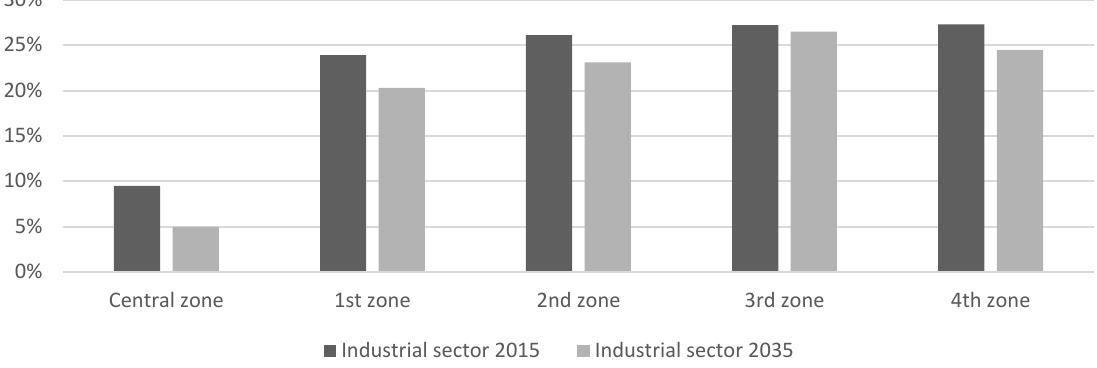
Figure 4. Forecast of the share of the industrial sector in the economic structure of Ekaterinburg micro-districts